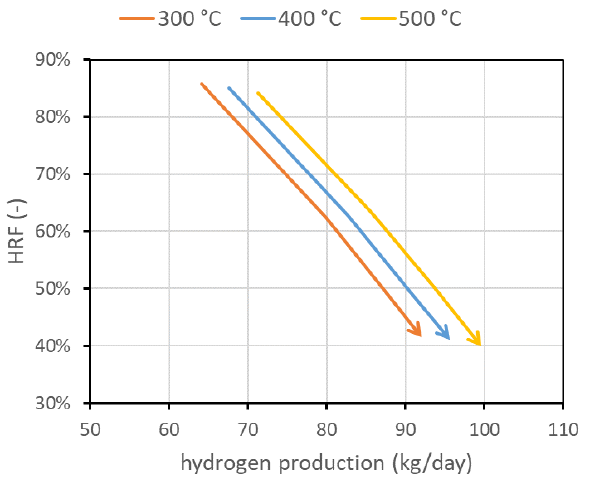
Figure 9. Performance chart obtained for different feed temperatures, maintaining reactor tempera- ture at 500 °C in all cases.